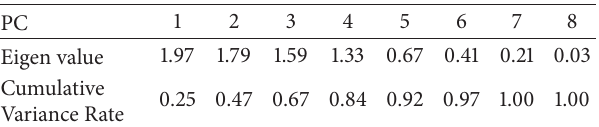
Figure 4: The structure of the WMLR model. Table 1: Eigen value and cumulative variance contribution rate of the 8 principal